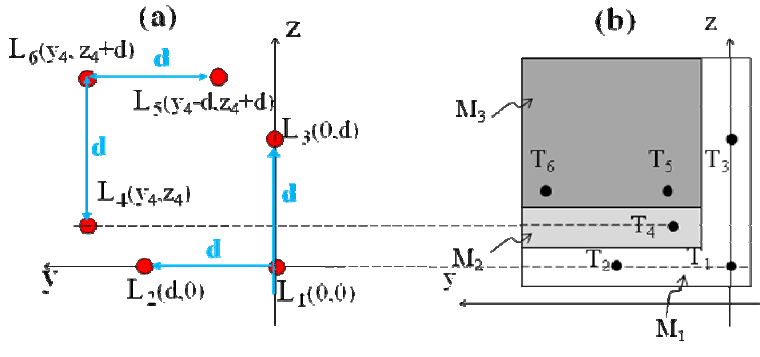
and (b) of the corresponding Figure 13. (a) Possible arrangement of the six laser sources L i target configuration in a 6 DOFs sensor. Dimensions are d = 50 mm, (y ,z ) = (65,15) mm, 4 4 M = 70  70 mm 2 , M = 10  60 mm 2 , M = 60  50 mm 2 . T (i = 1,2,3) indicate the fixed 1 2 3 i spots of L (i = 1,2,3). T (i = 4,5,6) indicate the point of incidence of L (i = 4,5,6) when the i i i target is at the maximum distance x . For x < x T moves horizontally away from the max max 4 z-axis and T move vertically away from the 5,6